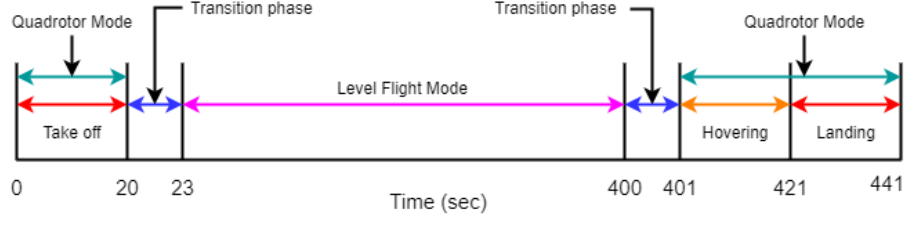
Figure 4. Timeline for trajectory-tracking.